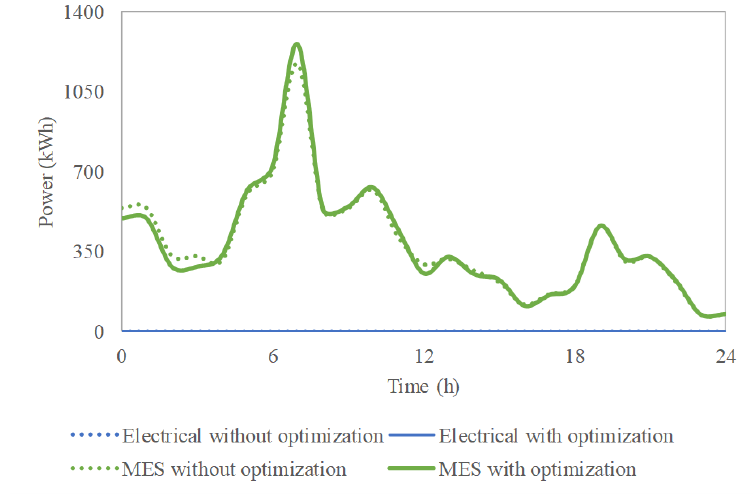
Figure 11. Gas consumed in the